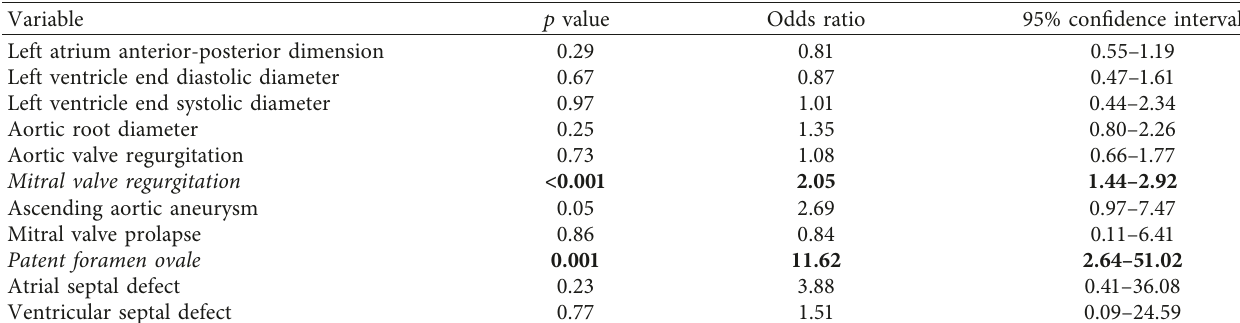
Table 2: Logistic regression analysis of the echocardiographic parameters and pathologies associated with atrial septal aneurysm.